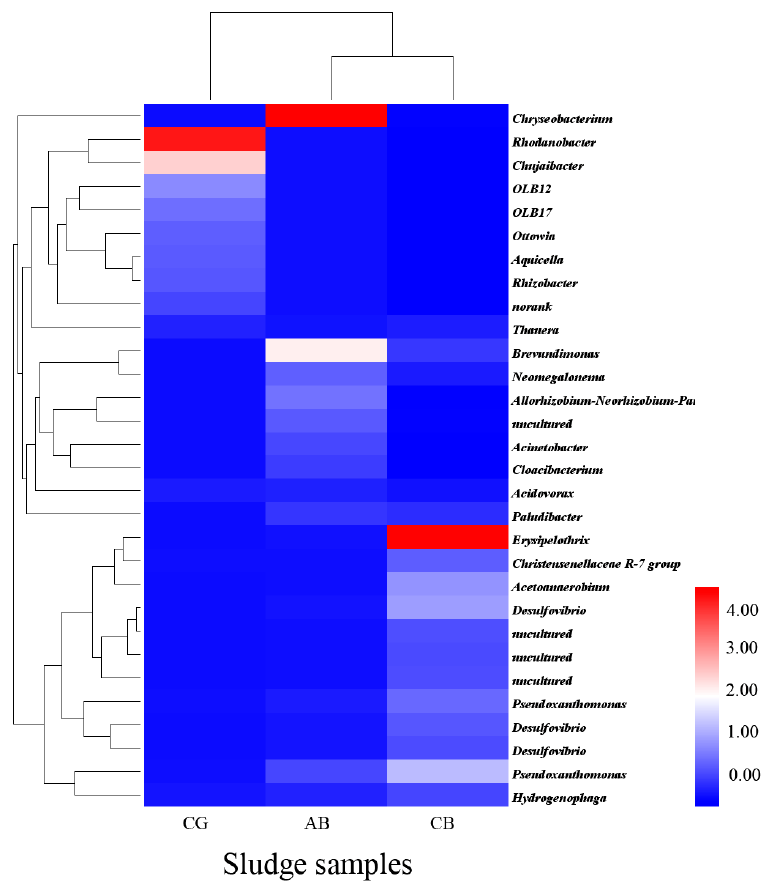
Figure 6. Microbial communities heat map analysis of 3D-BERs at genus level.